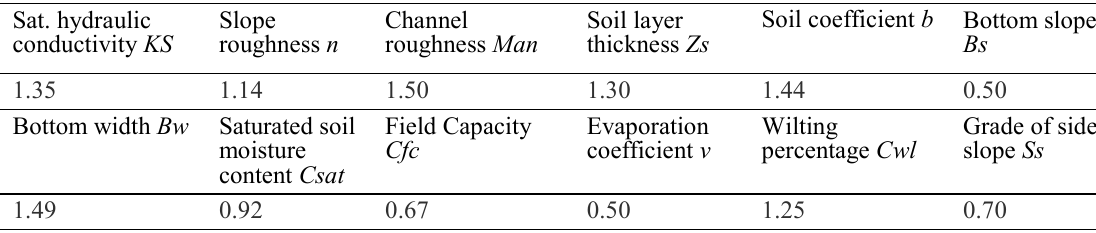
Table 3 Results of the parameter adjusting coefficient.